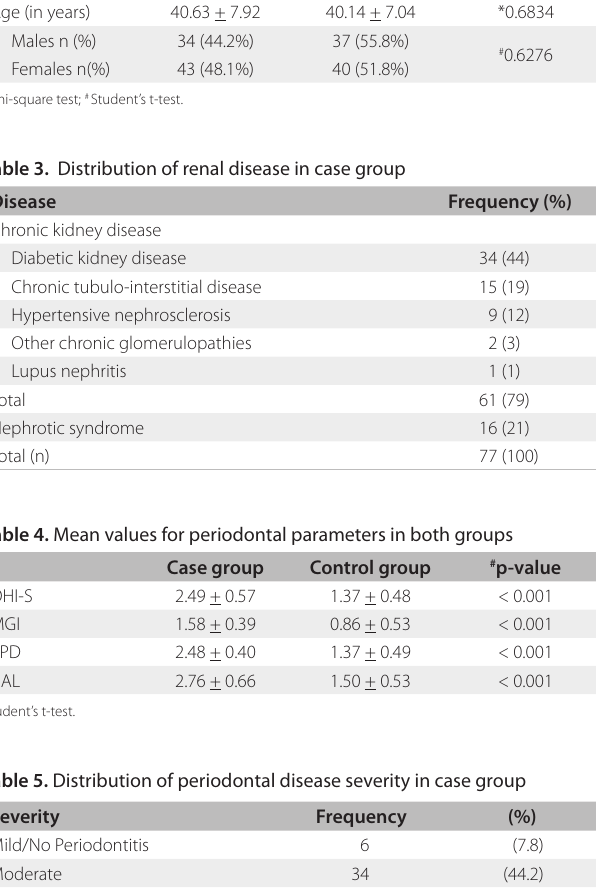
Table 2. Group wise distribution of age and gender Cases